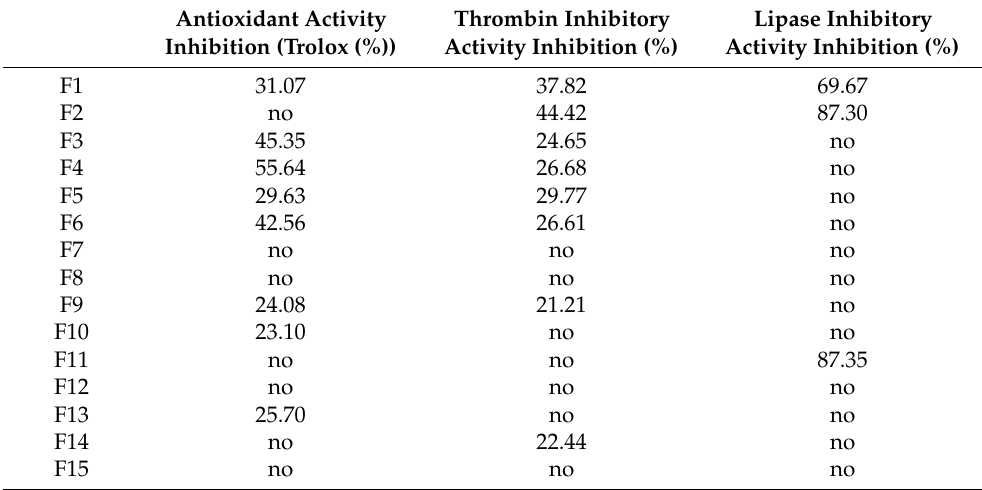
Figure 2. The multi-activity integrated chromatogram of antioxidant activity, inhibitory activity of thrombin and inhibitory activity of lipase. The chromatogram of red wine was shown in superstratum, substratum was a column diagram of each fraction for the three activities. Table 1. The data of antioxidant activity (expressed in Trolox), thrombin inhibitory activity (expressed in inhibition) and lipase inhibitory activity (expressed in inhibition).